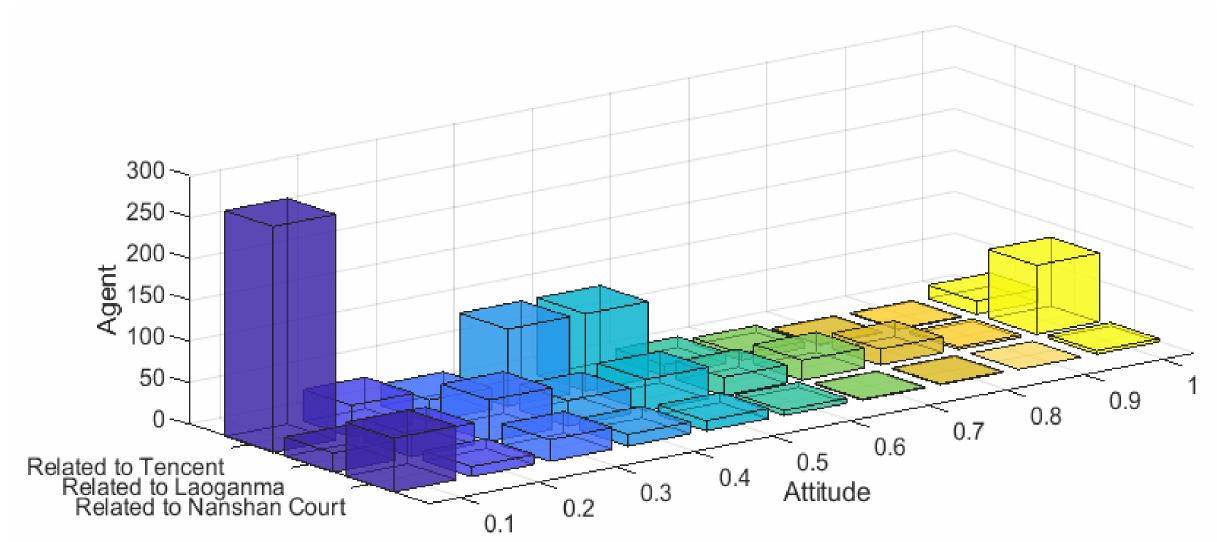
Figure 25. The distribution chart of public opinion based on constructed